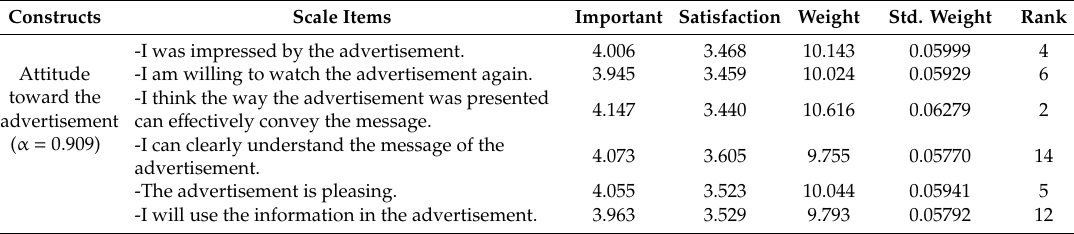
Table 2. Constructs, scale items, and standard weight of advertising e ff